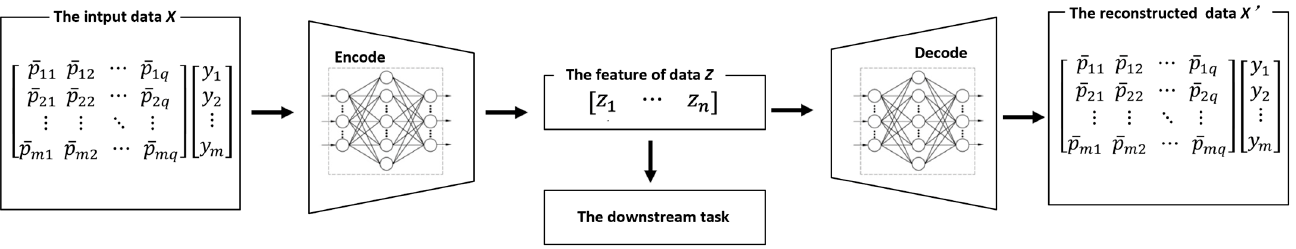
Figure 3. Auto-Encoder’s specific structure.